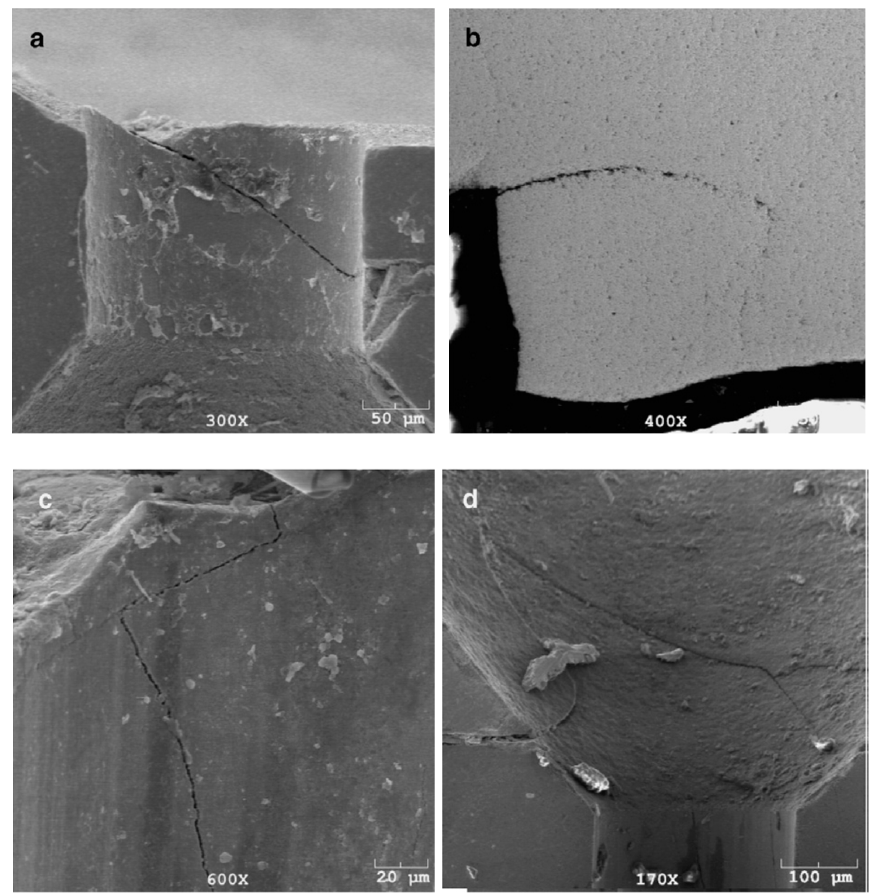
Figure 34. Failure modes of WC–6%Co drawing dies: ( a ) slanted crack, ( b ) combination of horizontal and vertical cracks, ( c ) multidirectional cracks, and ( d ) branched cracks. Reprinted with permission from ref. [86].